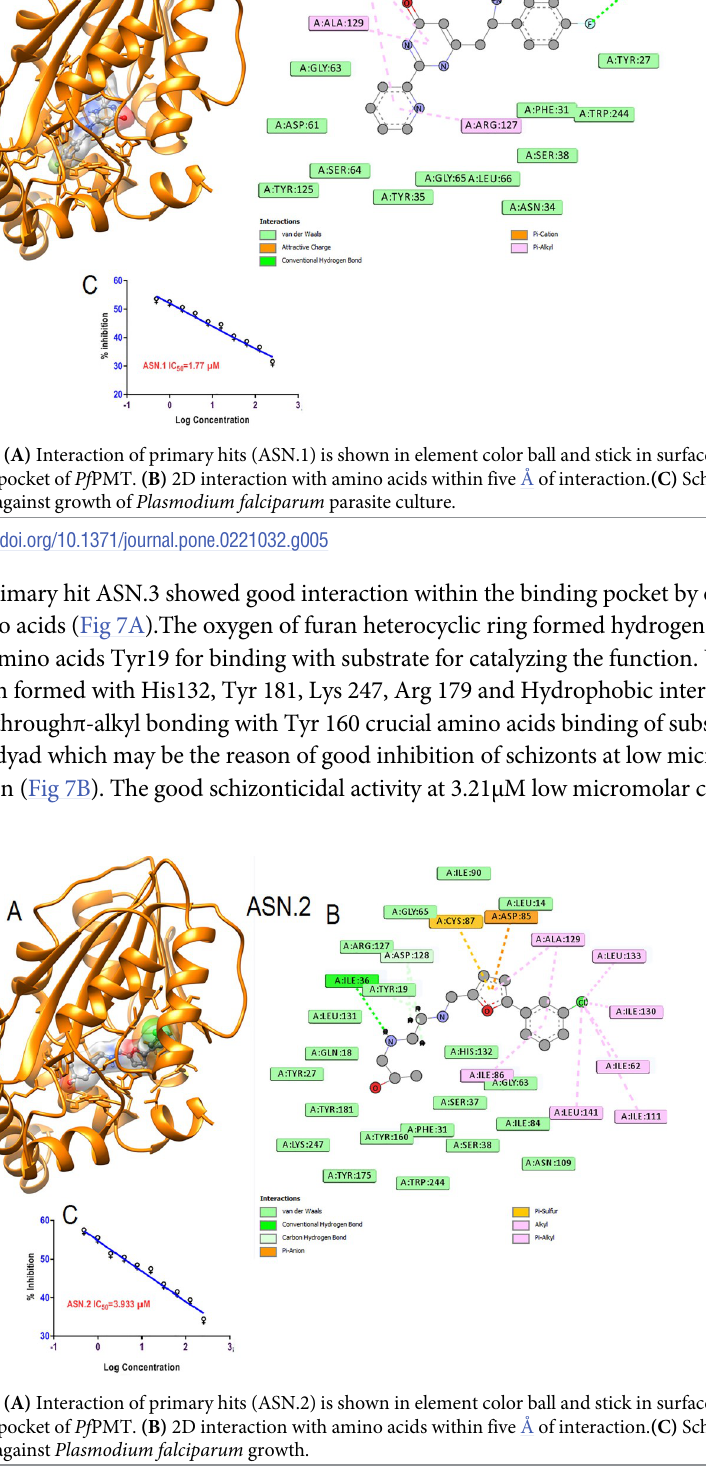
Fig 6. (A) Interaction of primary hits (ASN.2) is shown in element color ball and stick in surface view within the active pocket of Pf PMT. (B) 2D interaction with amino acids within five Å of interaction. (C) Schizonticidal activity (IC 50 )against Plasmodium falciparum